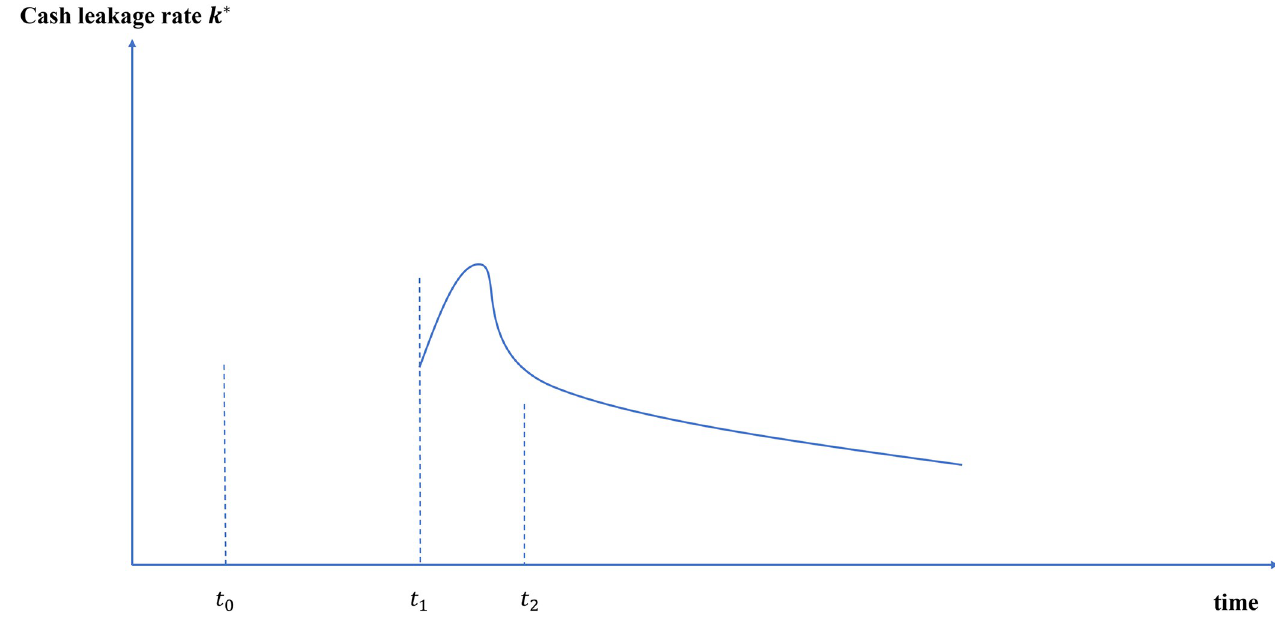
Fig 10. Path changes of cash leakage rate after e-CNY issuance.